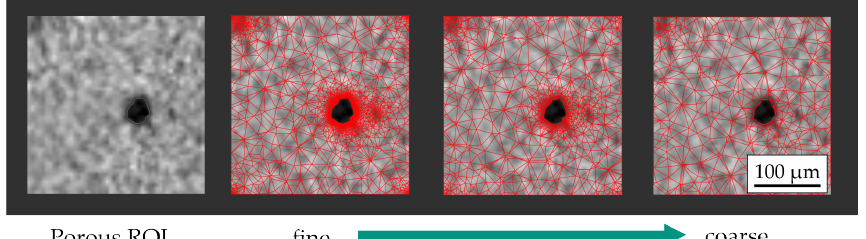
Figure 4. Trade-off between the computational effort and accuracy exemplified by an ROI with a single pore.